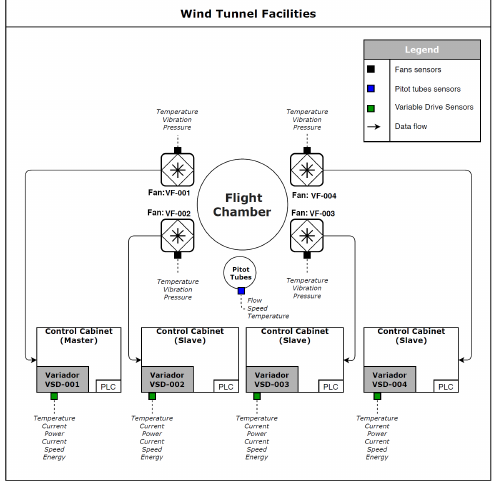
Figure 2. Wind tunnel system